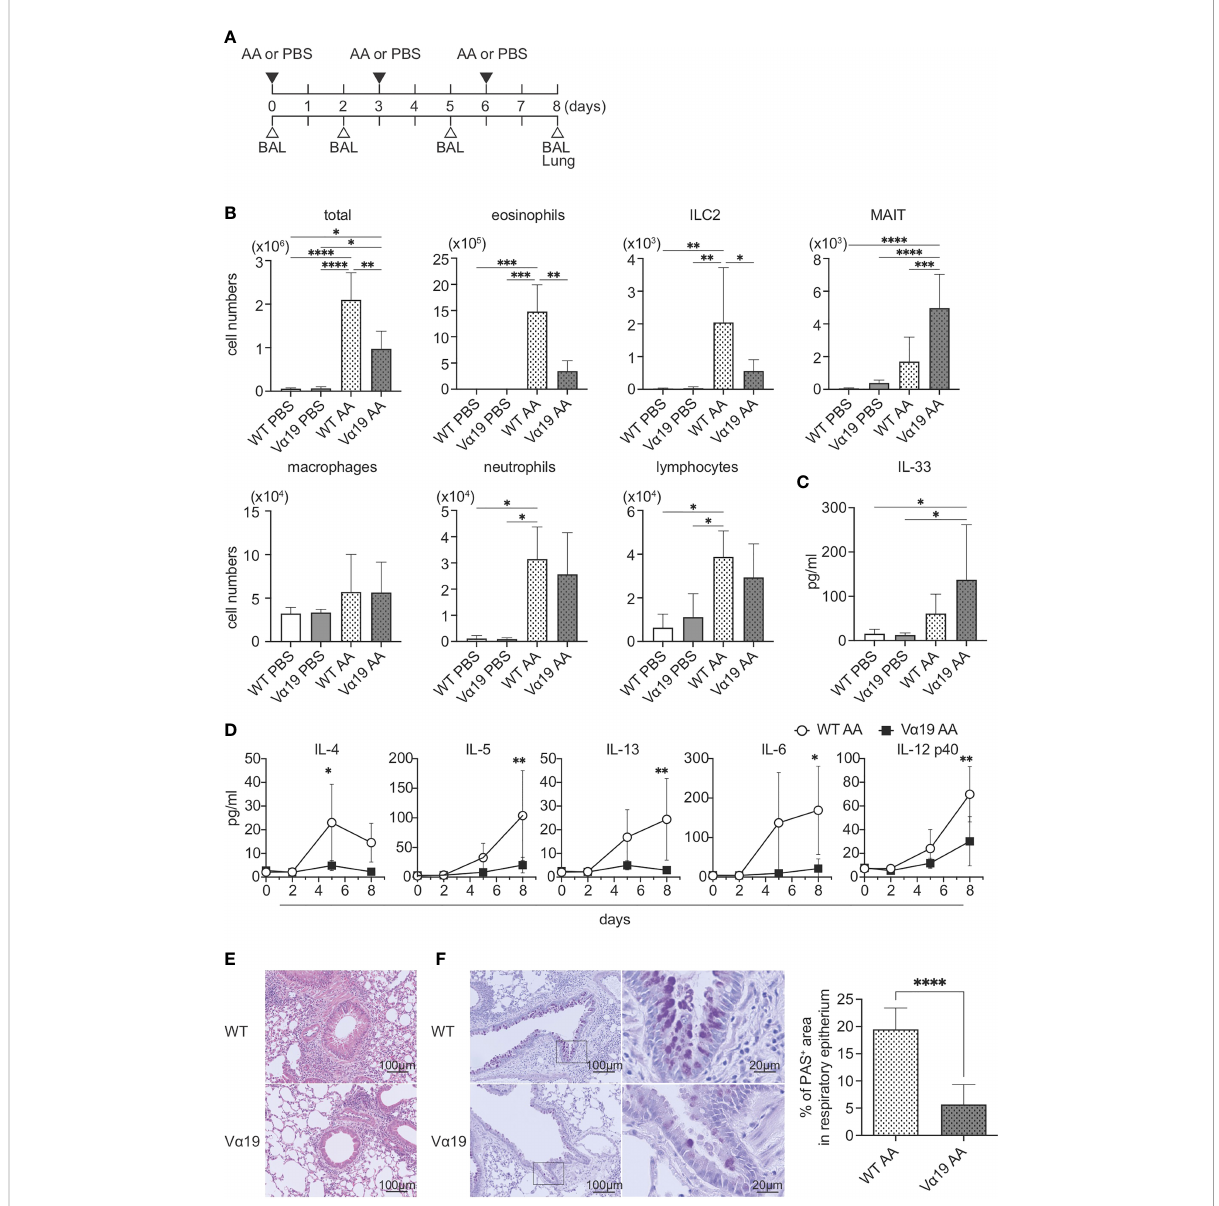
FIGURE 1 Mitigated lung in fl ammation in V a 19 mice upon the A alternata challenge (A) Schematic representation of the experiment. The challenge as well as the sampling schedule are indicated (AA: A alternata challenge, PBS: phosphate-buffered saline challenge) (upper panel), BAL: bronchoalveolar lavage, and the lungs (lower panel). A alternata extract (10 m g in 50 m l PBS) or PBS (50 m l) was intranasally challenged on day 0, 3 and 6. (B) Quanti fi cation of cell subsets in BAL fl uid. The number of the indicated cell subsets in BAL fl uid (BALF) sampled on day 8 are shown. WT PBS: wild-type mice challenged with PBS, V a 19 PBS: V a 19 mice challenged with PBS, WT AA: wild-type mice challenged with A alternata , V a 19 AA: V a 19 mice challenged with A alternata. Data are shown as mean ± SD (n=4 per group), *P <0.05, **P <0.01, ***P <0.001, ****P <0.0001. Data from two independent experiments are shown. (C) IL-33 production upon the A alternata challenge. IL-33 concentrations in BALF from the indicated mouse groups 1 h after the challenge are shown. Data are shown as mean ± SD (n=4 per group). The mouse grouping is the same as that in (B) Data from two independent experiments are shown. (D) Time course of cytokine production. Cytokine concentrations in BALF at the indicated day after the challenge in A alternata -challenged wild-type (WT AA) and V a 19 (V a 19 AA) mice. Data are shown as mean ± SD (n= 4 per group), *P <0.05, **P <0.01. Data from at least two independent experiments are shown. (E, F) . Histological analyses of WT and V a 19 mouse lungs. (E) Lung tissue sections stained with hematoxylin and eosin on day 8 after the A alternata. challenge. WT: wild-type mice, V a 19: V a 19 mice (left panels). The scale bar indicates 100 m m. (F) Same as described in E, except that the tissue sections were stained with PAS. Scale bars indicate 100 m m and 20 m m, respectively (left panel). Imaging of PAS stain was obtained with analysis software (inform, ver.2.6) equipped in Mantra2. The percentage of the PAS-positive area relative to the total surface of epithelial cells is shown as mean ± SD (n=4 per group) (right panel), ****P <0.0001. Data from at least fi ve different views were used for